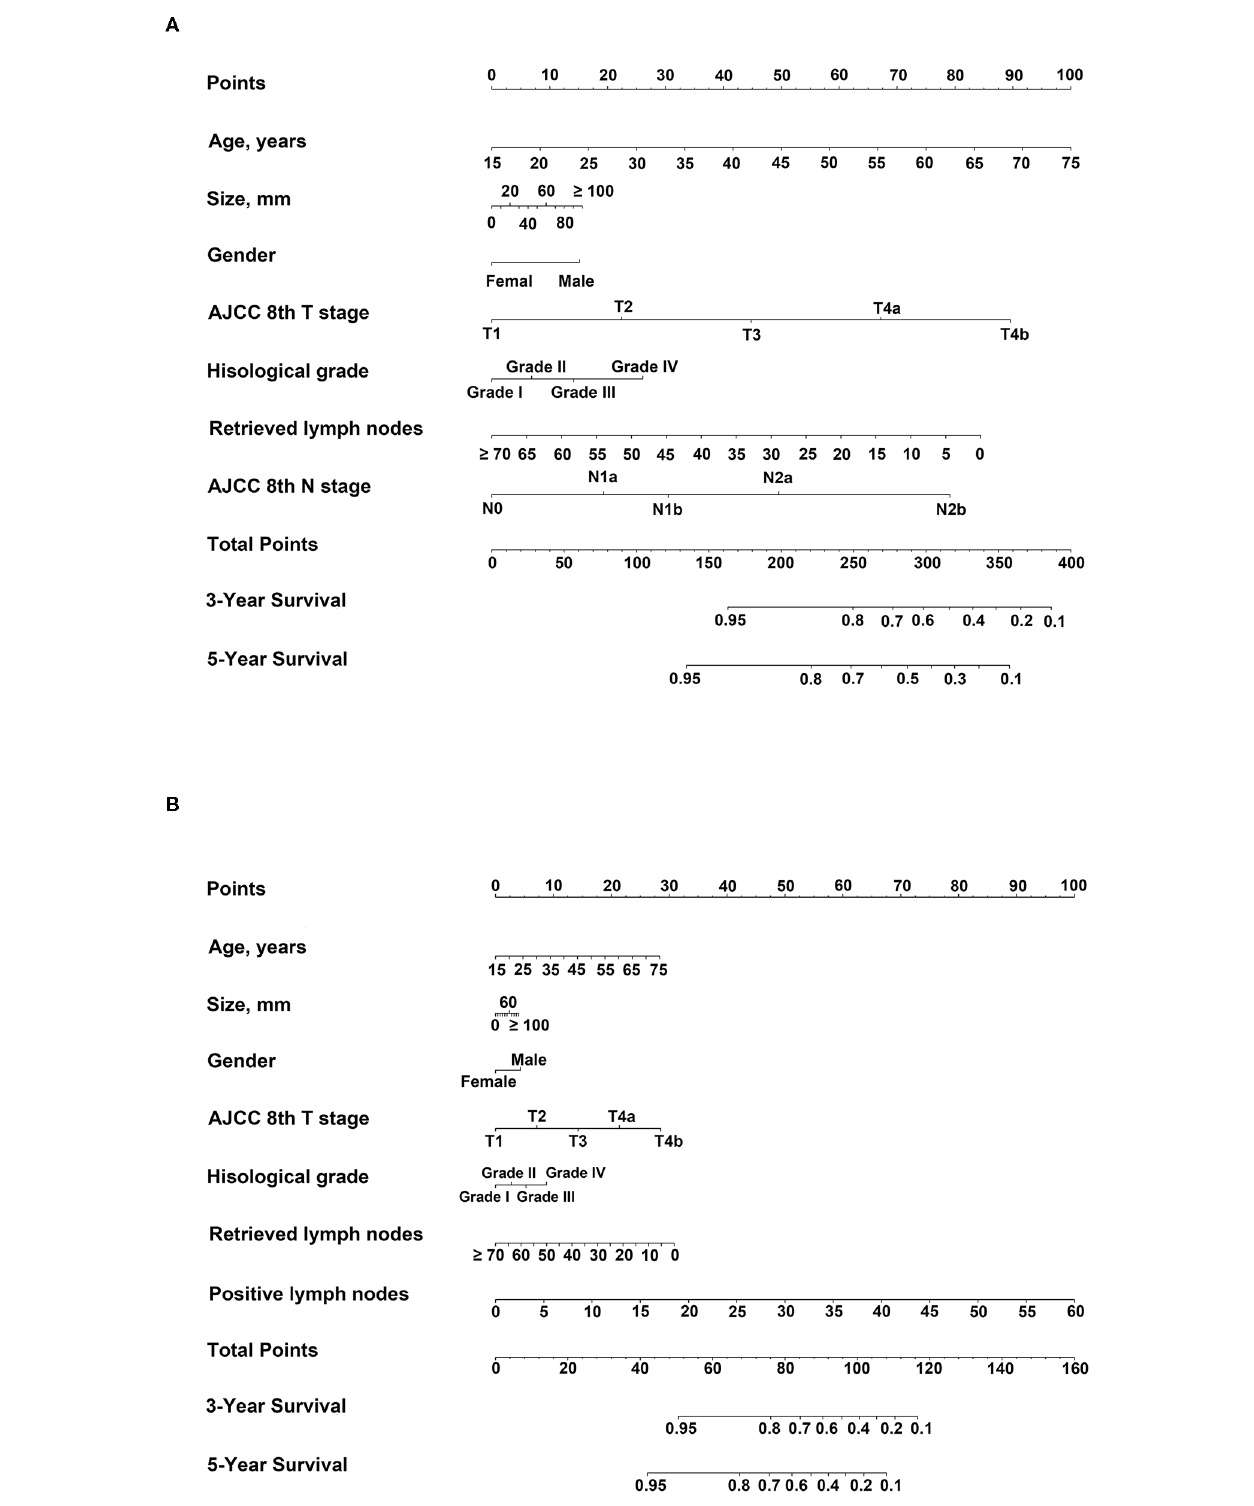
FIGURE 2 | Nomograms predicting three- and five-year overall survival (OS). For each patient, corresponding clinicopathological feature points were calculated and summed up to obtain total points. Predicted three- and five-year OS can be estimated based on total points for each patient. (A) Nomogram 1: variables included age, gender, histological grade, AJCC 8th T stage, tumor size, retrieved lymph nodes, and AJCC 8th N stage; (B) Nomogram 2: variables included age, gender[[Inline Image]], histological grade, AJCC 8th T stage, tumor size, RLNs, and number of positive lymph nodes.